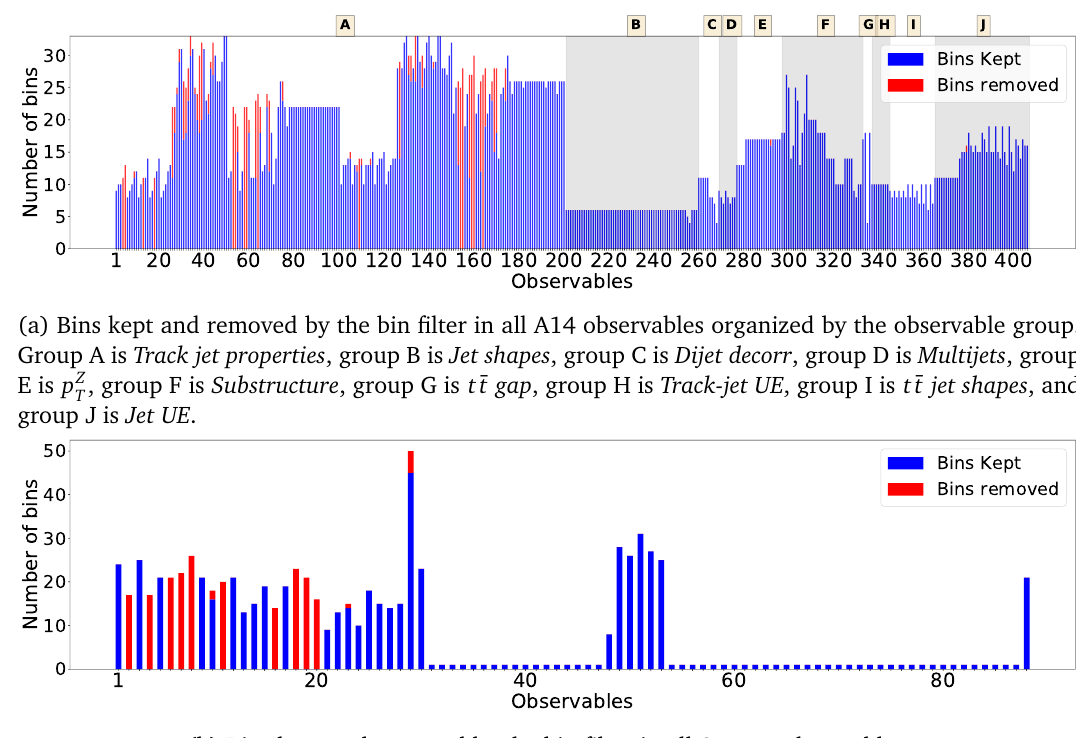
Figure 1: Illustration of the bin filtering results.